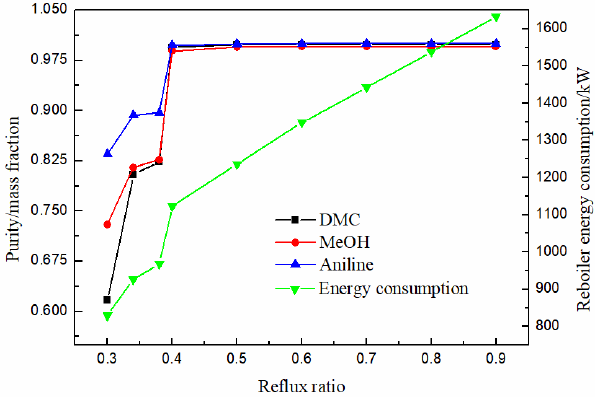
Figure 11. Effect of reflux ratio on product purity and heat duty of reboiler.